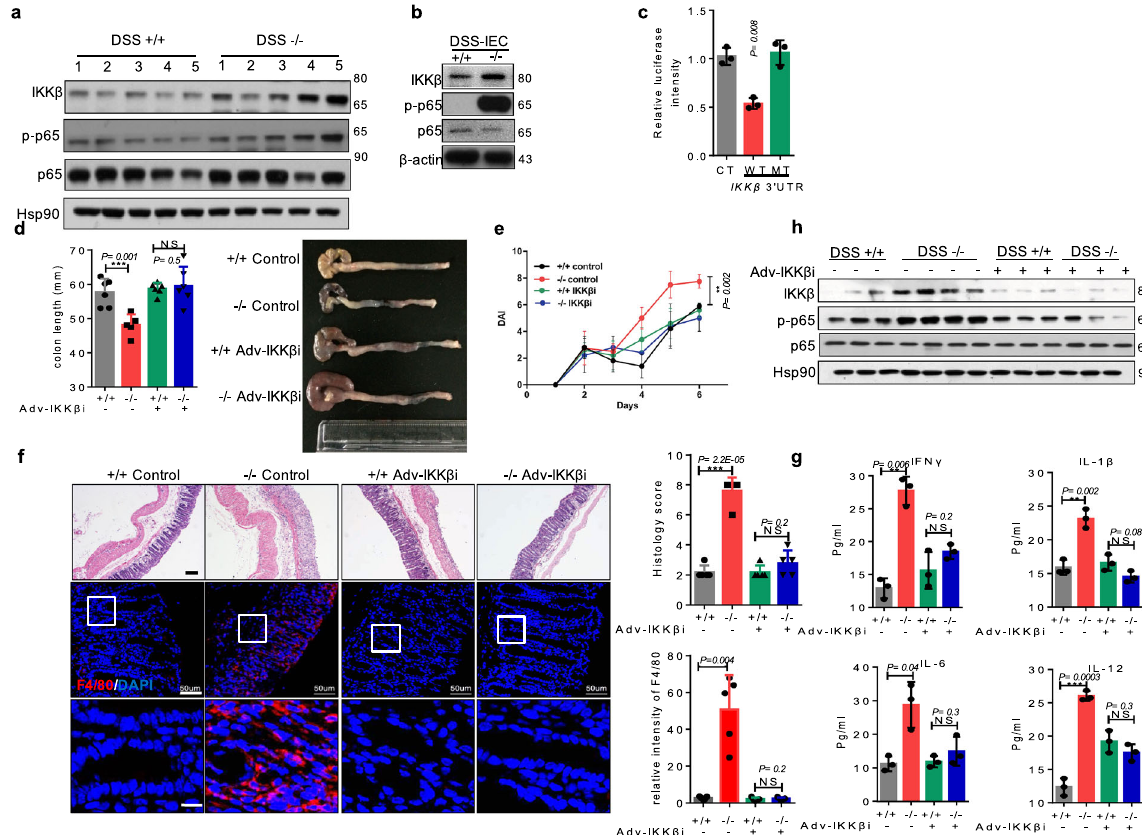
Fig. 6 miR-494-3p de fi ciency in differentiated IECs contributes to colitis via directly regulating IKK β . a , b Western blot of colon tissues ( a ) and IECs ( b ) from DSS-treated miR-494 − / − mice or WT ( + / + ) mice on day 7. c Luciferase activity of the reporter vector containing the sequence of WT or mutant 3 ′ - UTR of IKK β was determined after co-transfection with control or miR-494-3p mimic. d – h IKK β interference adenovirus (Adv-IKK β i) or control adenovirus was administered to miR-494 − / − mice and WT ( + / + ) mice by coloclysis and mice then were provided with free access to 3% DSS in drinking water for 7 days. The number of each group = 5. d Colon length was measured on day 7 after killing. e The plot showing DAI. f Images of H&E (scale bar: 200 μ m) and IF staining for macrophage marker F4/80 (scale bar: 50 μ m, scale bar of close-up image: 5 μ m) in colon tissues at day 7; the right two plots showing histology score (0 – 12) (upper panel) and quanti fi cation of the number of F4/80 + cells (lower panel). g Levels of indicated cytokines were determined by ELISA in plasma at day 7. h Western Blot of colon tissues at day 7. Data are presented as mean ± S.D. and analyzed by non-paired two-tailed Student ’ s t- test in the graphs in ( a , d – g ). *** P ≤ 0.001; ** P ≤ 0.01; * P ≤ 0.05; NS, no signi fi